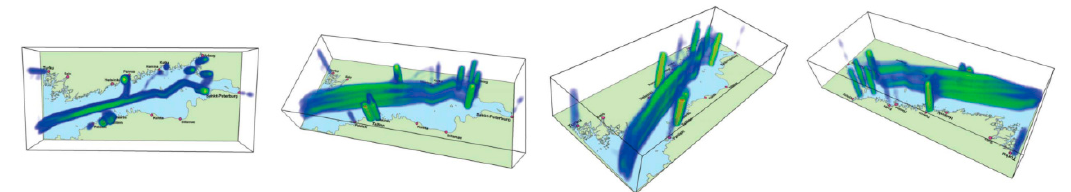
Figure 13. Space–time density of tankers displayed from different perspectives [44].